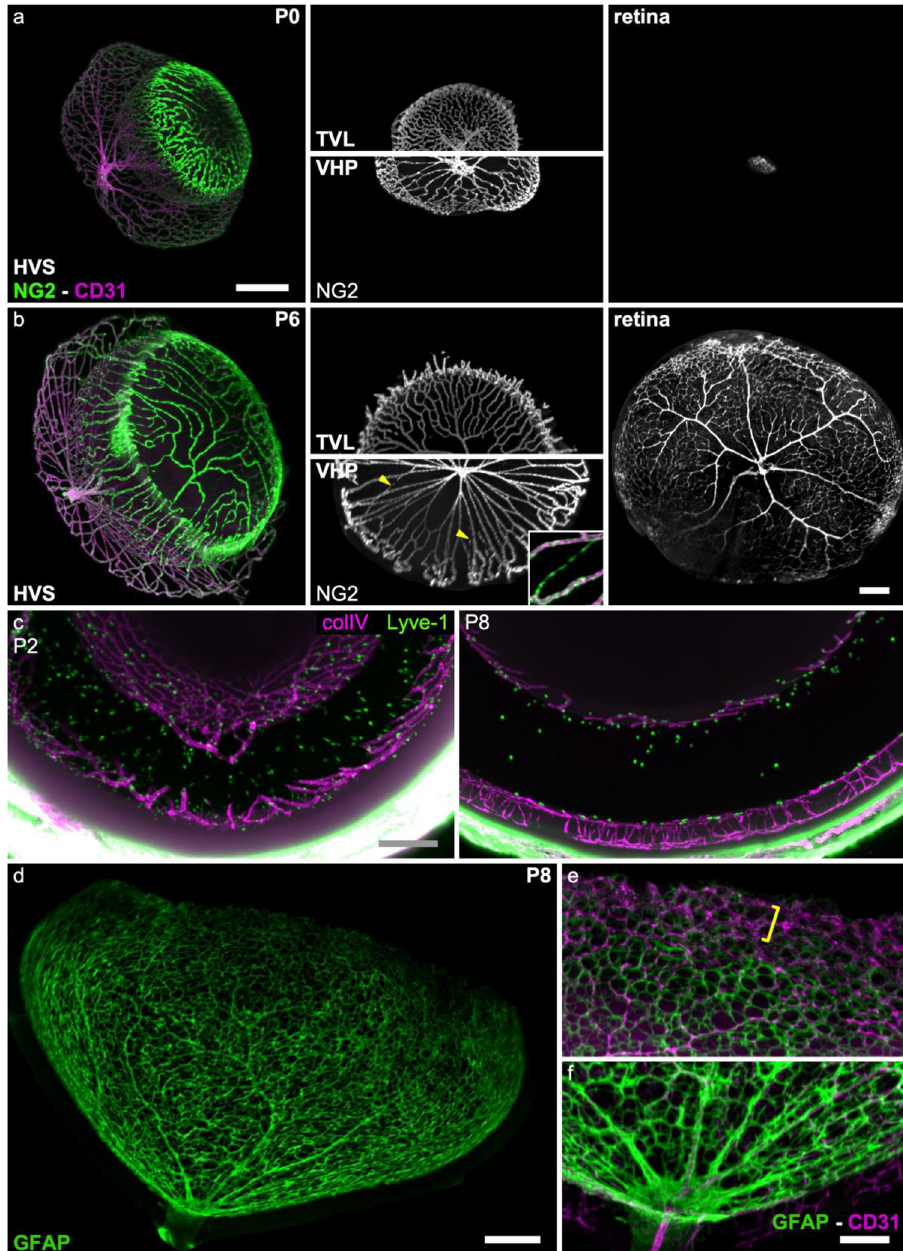
Fig. 4 perivascular cells during postnatal development. a , b NG2 (pericytes, green) and CD31 (endothelial cells, magenta) expression in P0 and P6 hyaloid and retinal vessels. Note that NG2-expressing cells are present at the earliest stage of hyaloid and retinal vascular development in all layers. First column shows a 3D view of all hyaloid vasculatures, second and third show an en-face view of TVL, VHP and retina NG2 expression, respectively. Yellow arrowheads: regressing vessels, insert: detail of a regressing vessel with double staining: anti-NG2 green, anti-CD31 magenta showing the pearl string-like appearance, where only the endothelial cell remains. c Lyve-1-expressing hyalocytes ’ presence in the vitreous and around the HVS. A portion of those hyalocytes surround the hyaloid blood vessels. Between P2 and P8 note the drastic decrease in the number of observed hyalocytes in the vitreous. d – f Astrocytic pattern in the developing retina (P8) through GFAP expression. LFSM of anti-GFAP (green) and anti-CD31 (magenta) immunolabeled retina at P6 showing the glial scaffold accompanying the development of the vasculature. The GFAP negative tip of the vascular front (not covered by astrocytes) is bracketed E. scale bar (Scale bars in each line are identical for panels a , b , c . Scale bars values:a, c , d : 200 µ m; b and e : 100 µ m; VHP:vasa hyaloidea propria, TVL tunica vasculosa